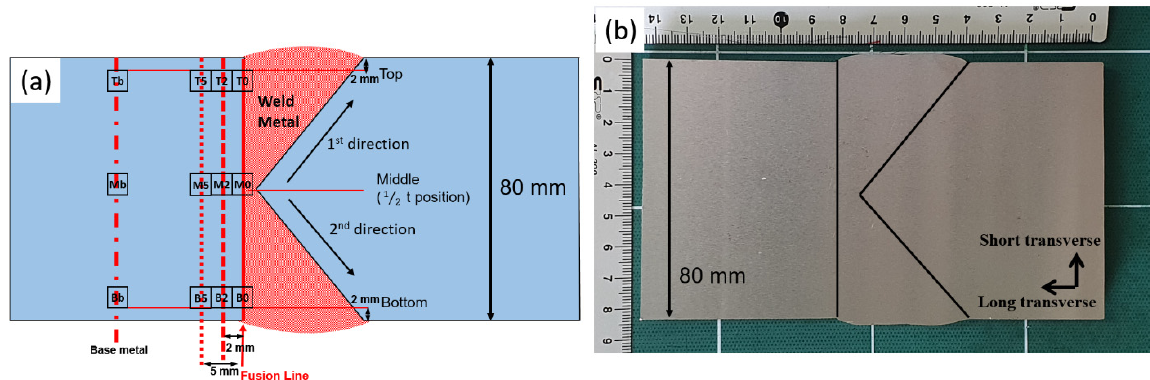
Figure 2. ( a ) Schematic illustration, ( b ) optical images of the welding joint and sampling positions of the specimens. Table 2. Specimen information according to the twelve positions.